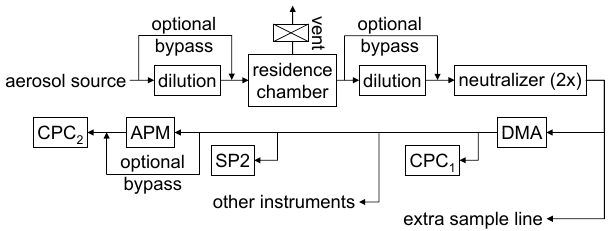
Fig. 1. Experimental setup for the measurement of effective density and SP2 counting efficiency of laboratory-generated soot